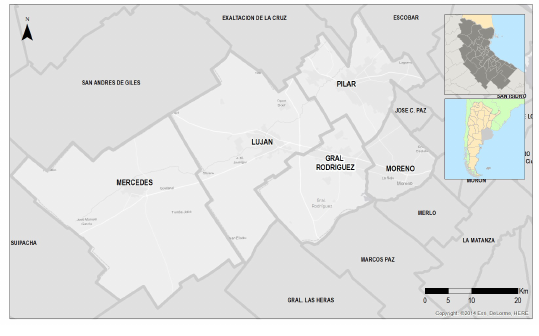
Figure 1. Map of the study